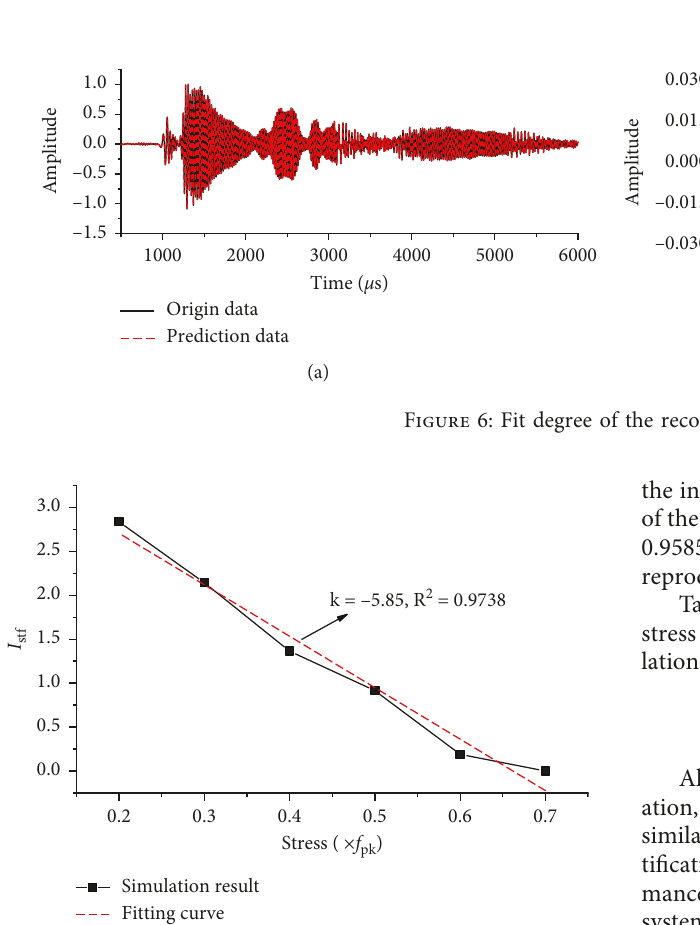
Figure 7: Relationship curves between the recognition index and the tensile